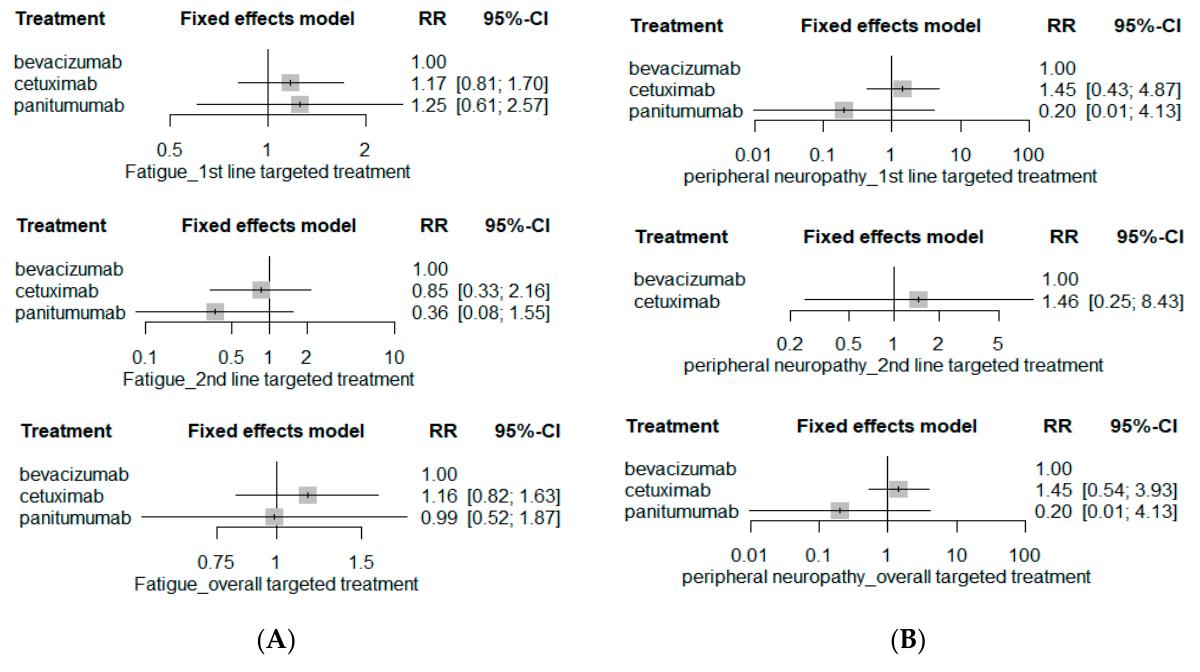
Figure 5. GI SAE risks. ( A ) Anorexia; ( B ) nausea; ( C ) vomiting; and ( D ) diarrhea.